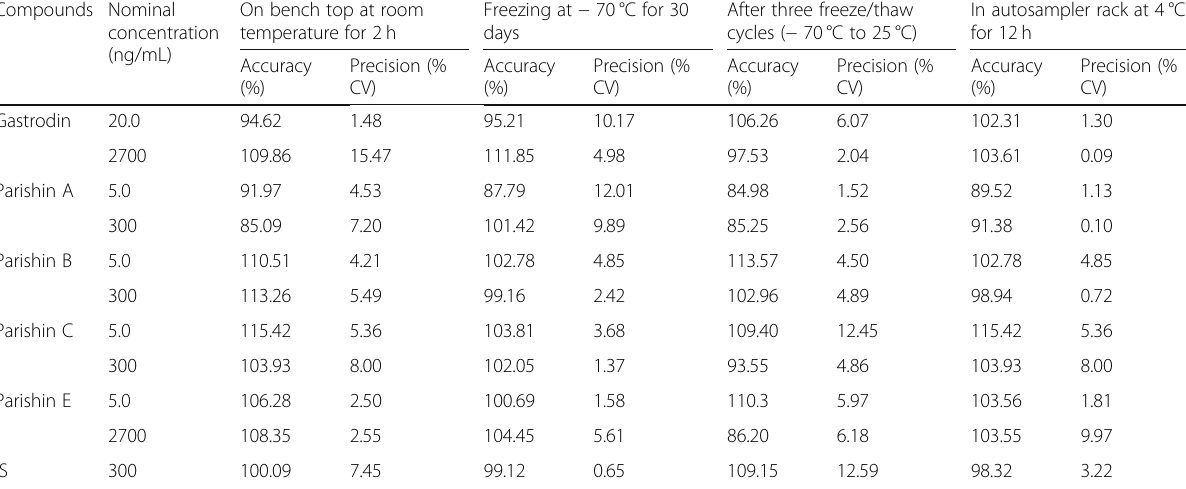
Table 4 Stability data of the five analytes and I.S. in rat plasma under different conditions Compounds Nominal On bench top at room concentration temperature for 2 h (ng/mL)